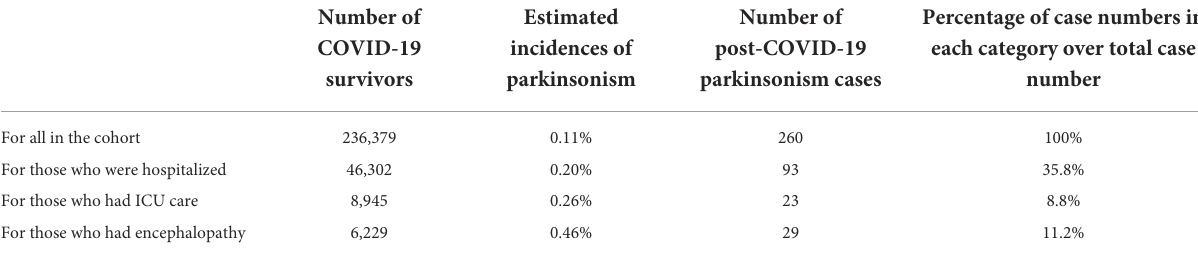
TABLE 4 Summary of the estimated incidences and numbers of post-COVID-19 parkinsonism reported in Taquet et al.